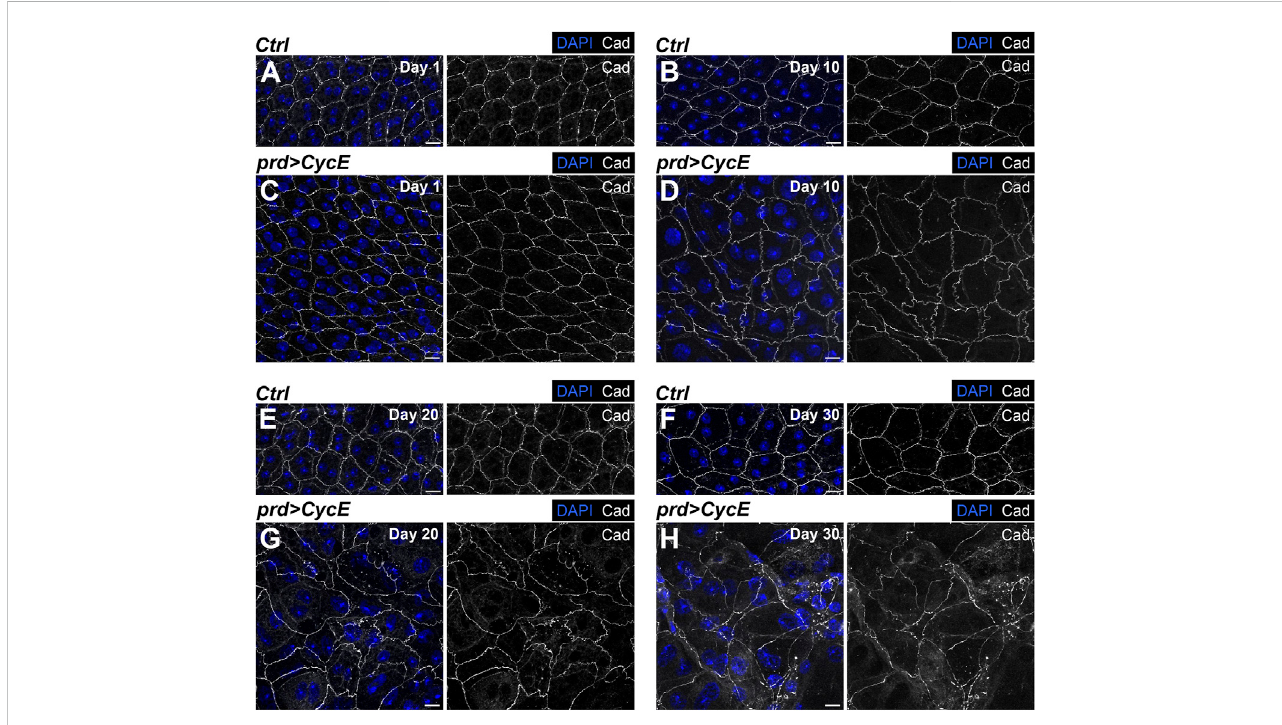
FIGURE 4 Cyclin E overexpression perturbs epithelial integrity. (A – H) Confocal images of 1-, 10-, 20- and 30-day-old control ( prd-Gal4/+ ) [ (A,B,E,F) , respectively] and prd > CycE glands [ (C,D,G,H) , respectively] stained with anti-DE-Cadherin. DAPI and Cad are shown in blue and grays, respectively. Scale bars, 10